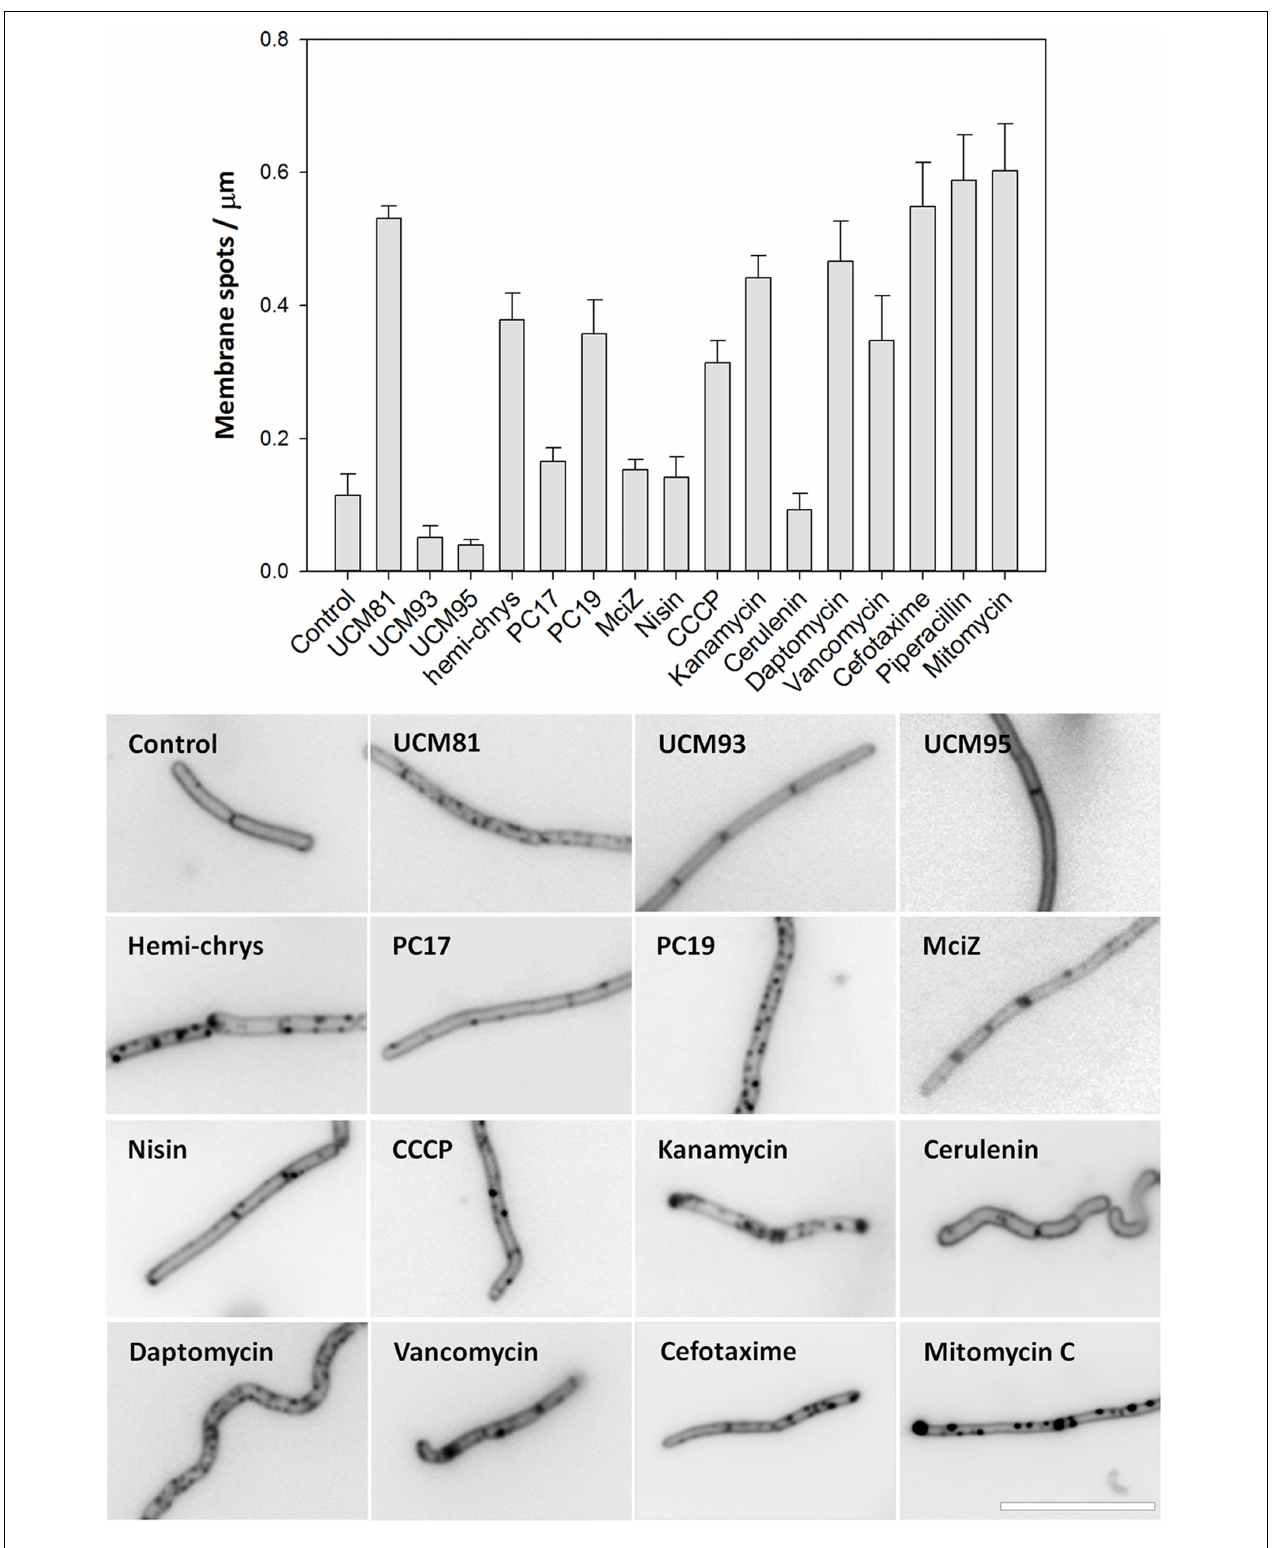
FIGURE 6 | Membrane morphology in cells treated with FtsZ inhibitors and other antibiotics. B. subtilis 168 cells grown in the presence or absence of compounds during 3 h and before microscopic analysis they were stained with 5 µ g/mL of FM4-64. The number of small membrane spots per micron were determined (graphic; average and standard error are shown, n = 3). Scale bar: 10 µ m.